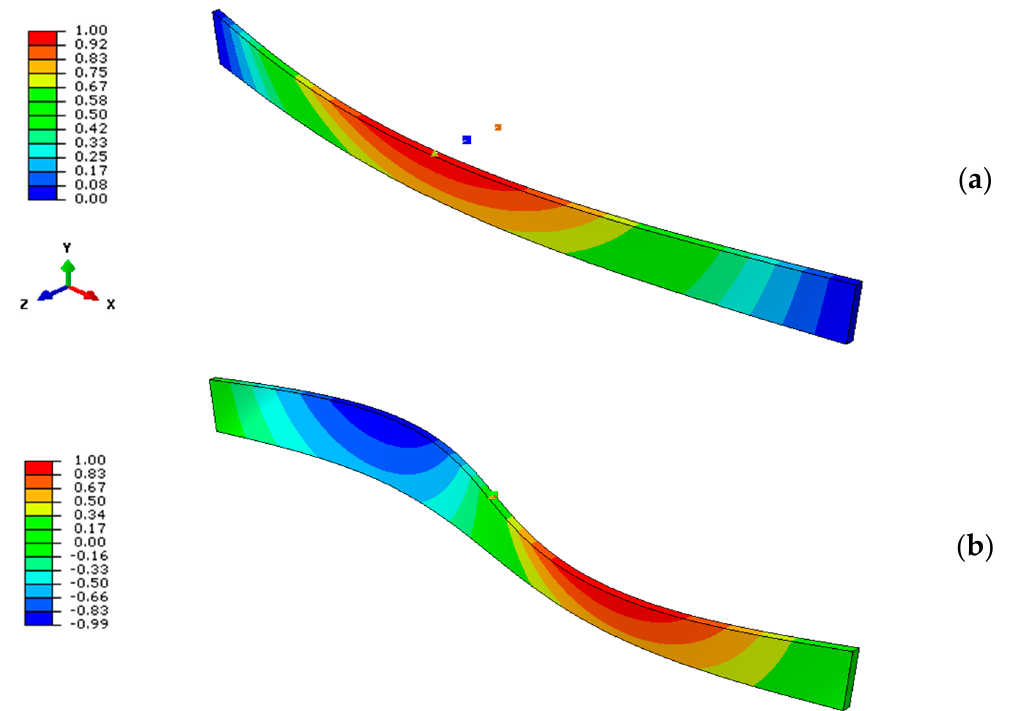
Figure 14. Typical LTB deformed shape for a selected LR glass beam ( L = 2000 mm, b = 200 mm, t = 20 mm) with discrete lateral restraints ( n b = 1, with x b = L /2 and z b = b /2): ( a ) example of LU beam ( K → 0) and ( b ) LR limit condition ( K → K T ), using ABAQUS.